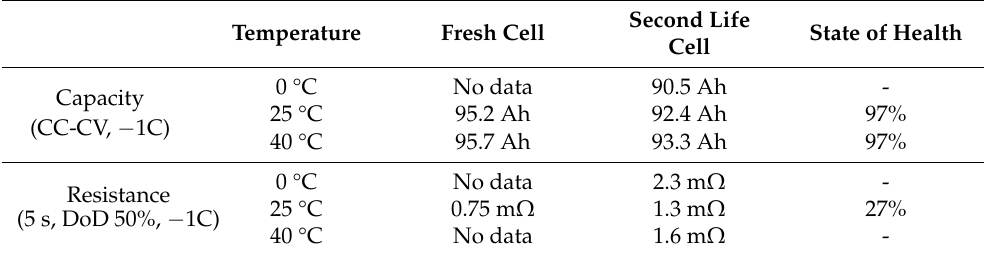
Table 3. Performance comparison between a fresh cell (datasheet) and a second life cell (experiments). “-” means that the state of health could not be